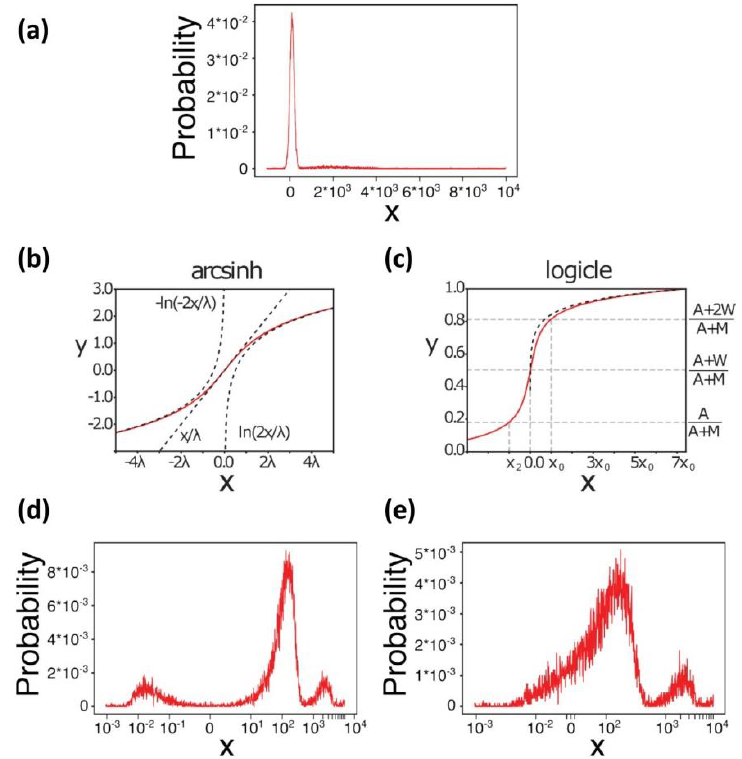
Figure 2. Data transformations. ( a ) A random data set was generated using two gaussian distributions, centered at 10 2 (10000 cells) and 2*10 3 (1000 cells), and with standard deviation equal to 10 2 and 10 3 , respectively. The probability histogram is shown on a linear scale. ( b ) Arcsinh transformation. The parameter λ defines both the width of the linear region, and its slope. The transforming function is approximately linear for λ close to zero, while it approaches logarithmic transformations when x >> λ or when x << − λ . ( c ) Logicle transformation. The shape of the transforming function is defined by the parameters M, A, and W, which can be intuitively interpreted respectively as the number of decades, the number of negative decades, and the width of the linear region. ( d ) Probability histogram of the data in a transformed with the arcsinh function. ( e ) Probability histogram of the data in a transformed with the logicle function.